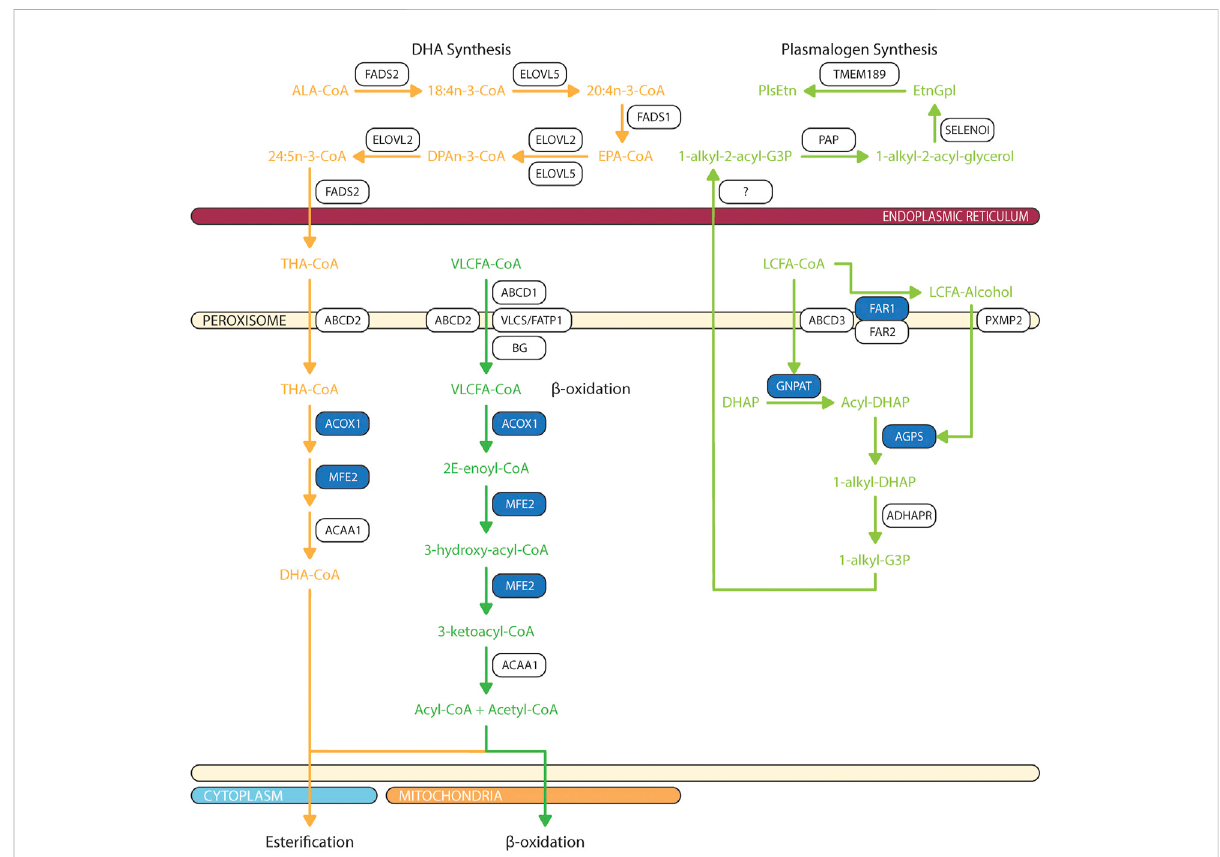
FIGURE 3 Biochemical pathways of peroxisomal lipid synthesis and degradation. Blue box represents enzymes with published pathogenic variants resulting in ocular manifestations in humans. ABCD, ATP-binding cassette sub-family D; ACAA, 3-oxoacyl thiolase; ACOX, acyl-CoA oxidase; ADHAPR, acyl/alkyl DHAP reductase; AGPS, alkyl-glycerone phosphate synthase; ALA, α -linolenic acid; BG, bubblegum; DHA, docosahexaenoic acid; DHAP, dihydroxyacetone phosphate; DPAn-3, n-3 docosapentaenoic acid; ELOVL, fatty acid elongase; EPA, eicosapentaenoic acid; EtnGpl, ethanolamine glycerophospholipids; FADS, fatty acid desaturase; FAR, fatty acyl-CoA reductase; FATP, fatty acid transport protein; G3P, glycerol-3-phosphate; GNPAT, glycerone-phosphate O-acyltransferase; LCFA, long chain fatty acids; MFE, multifuctional enzyme; PAP, phosphatidic acid phosphatase; PlsEtn, ethanolamine plasmalogens; PXMP2, peroxisomal membrane protein 2; SELENOI, selenoprotein 1 (ethanolamine phosphotransferase 1); THA, tetracosahexaenoic acid; TMEM189, plasmanylethanolamine desaturase; VLCFA, very long chain fatty acids; VLCS, very long chain acyl-CoA synthetase. The fi gure was partly generated using Servier Medical